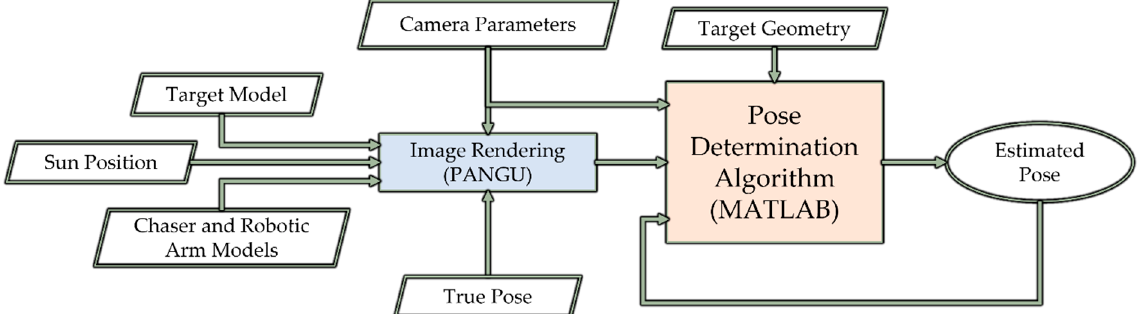
Figure 11. Block diagram representation of the simulation environment. The same structure is considered for both the cameras. The trajectory is generated accordingly based on the camera being considered for the simulation.